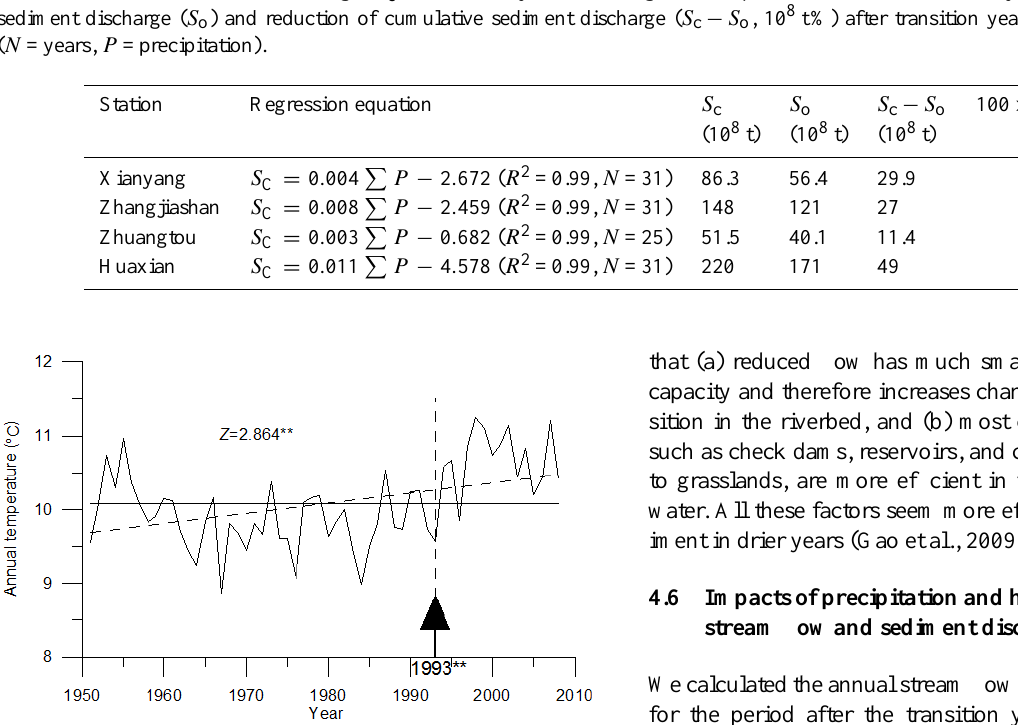
Fig. 4 Observed annual average temperature in the Wei River basin. The horizontal solid lines present the mean values for the flood season, the horizontal dashed lines indicate the trend line, the Z statistic was obtained from the Mann-Kendall test. ( **: p ＜